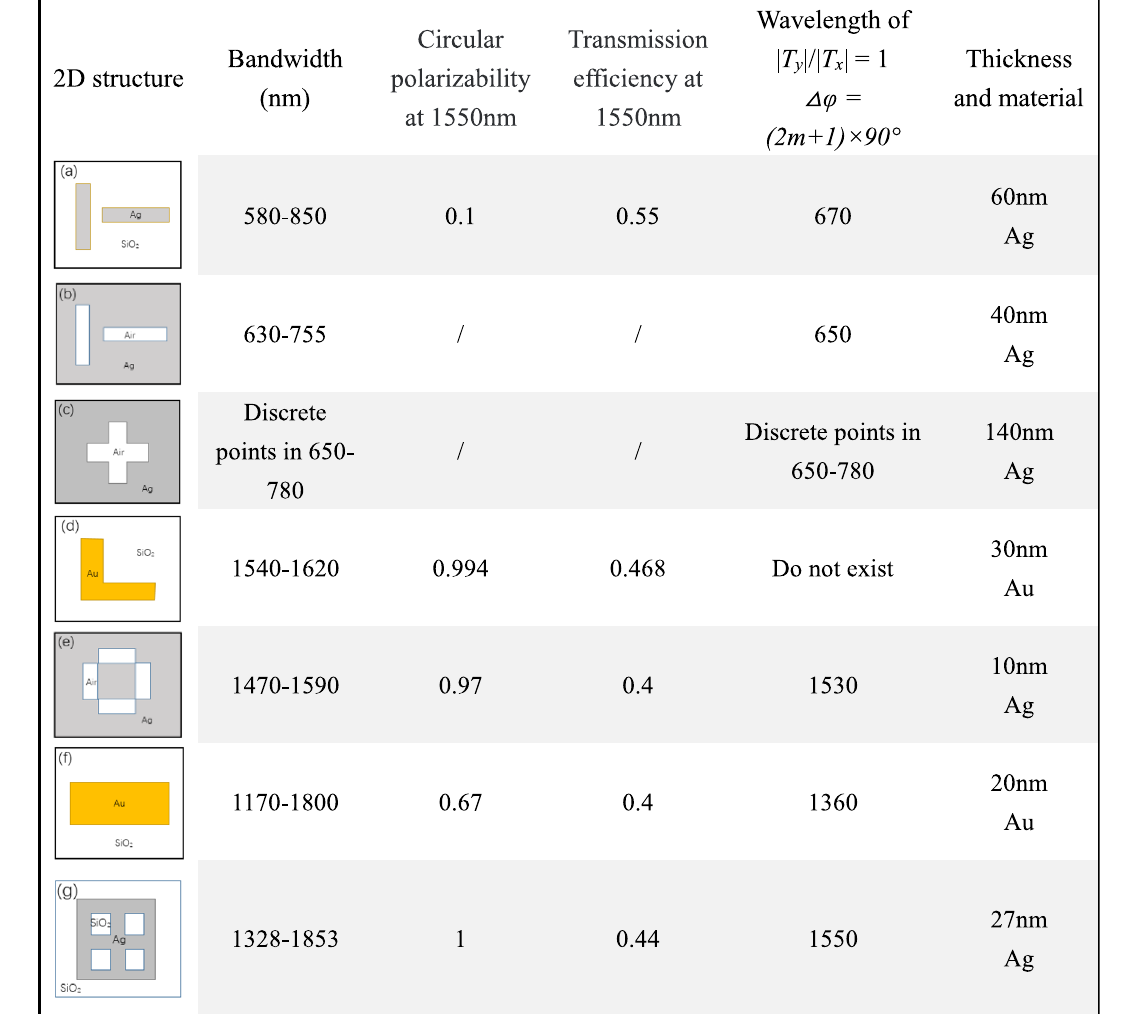
Table 1 Comparison of the characteristics of quarter waveplates in several papers mentioned